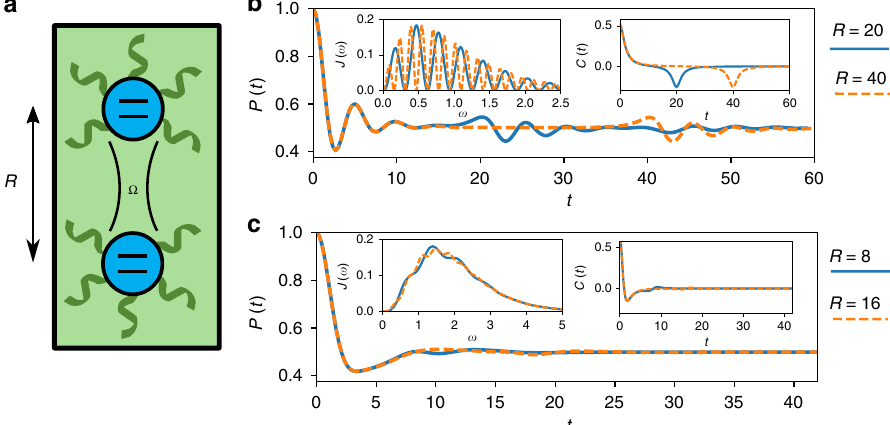
Fig. 4 Dynamics of two coupled spins-1/2, separated by a distance R , interacting with the same environment. a A schematic of this system. b , c Dynamics of the system in 1D and 3D, respectively, at different values of the spin separation R . Insets to these plots are the corresponding spectral densities and bath correlation functions (see Methods section for details). The dimensionless couplings α used for 1D and 3D are α = 2 and α = 1, respectively. We set the speed of sound c = 1, so that all parameters are in units of Ω and we choose T = 0.5, ω c = 0.5. In all cases we have used 180 timesteps, but not used the memory cutoff meaning K = 180